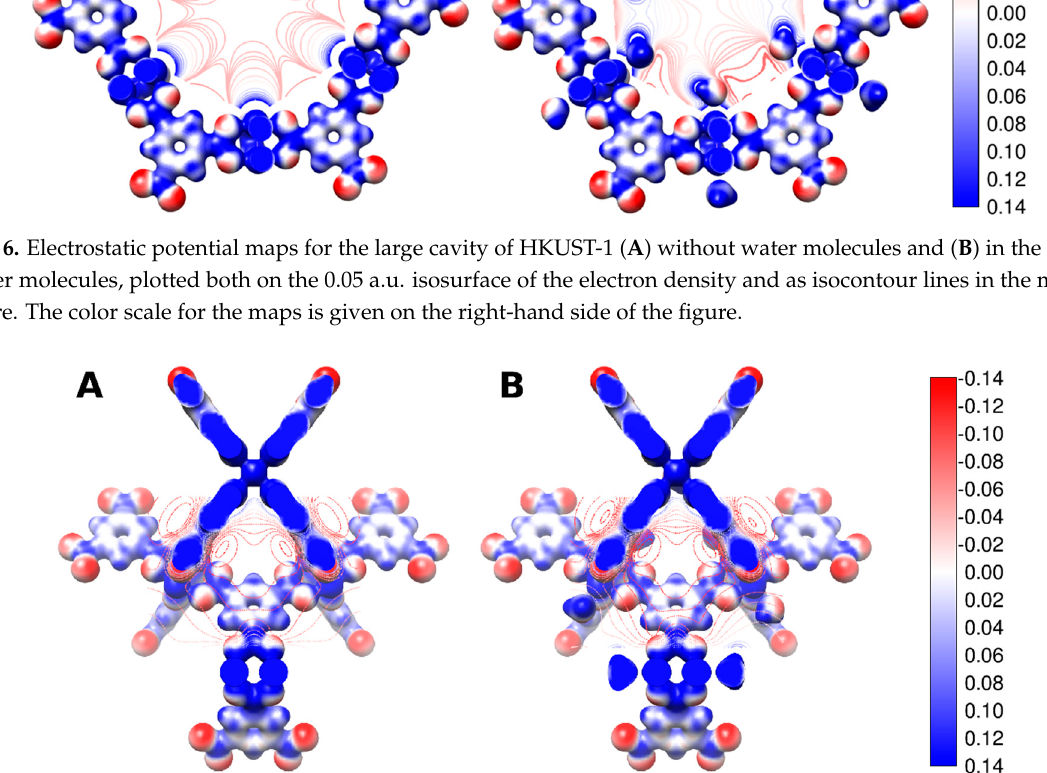
Figure 7. Electrostatic potential maps for the small cavity of HKUST-1 ( A ) without water molecules and ( B ) in the presence of water molecules, plotted both on the 0.05 a.u. isosurface of the electron density and as isocontour lines in the middle of the pore. The color scale for the maps is given on the right-hand side of the